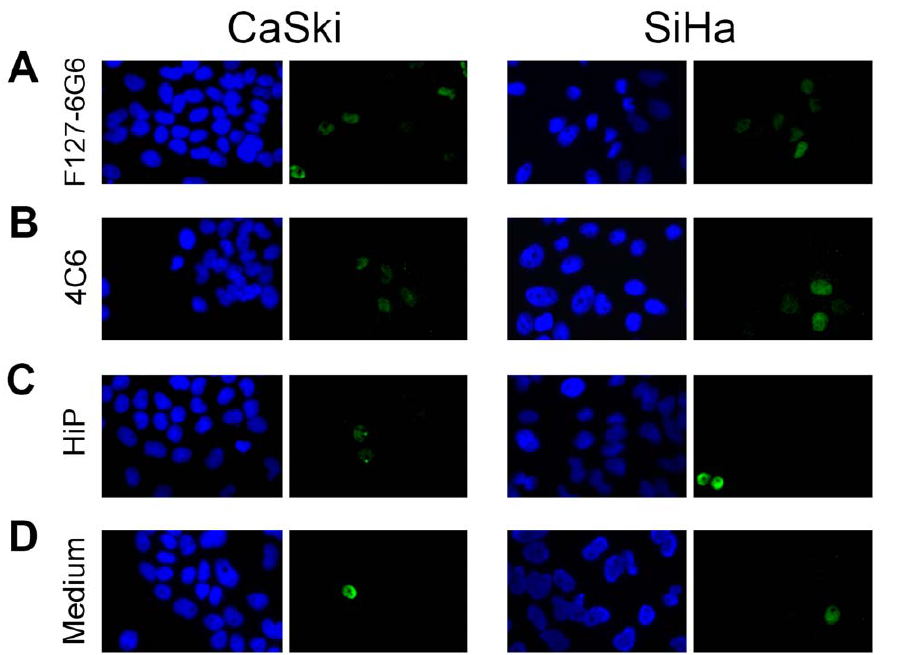
Figure 4. Immunofluorescence staining demonstrating p53 expression (green) following chemical transfection. (A) Transfection with 4 m g/mL F127-6G6 E6 antibody. (B) Transfection with 4 m g/mL 4C6 E6 antibody. (C) Cells treated with only the HiPerFect (HiP) transfection reagent. (D) Cells which received culture medium alone. Nuclei were counterstained blue with DAPI. Cells were visualized using 400 6 magnification 48 hours following transfection.